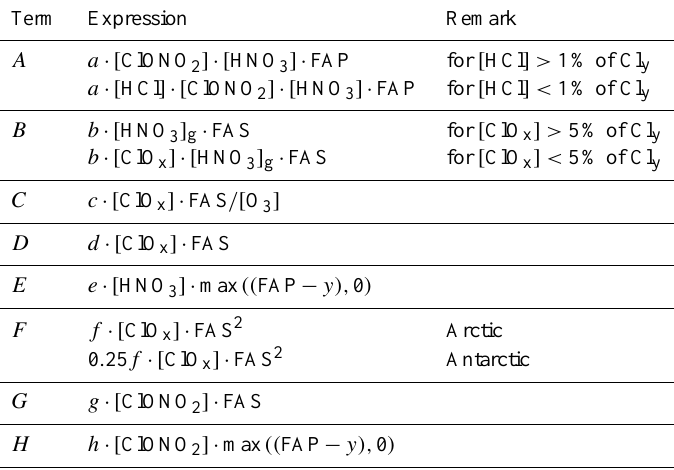
Table 2. List of the terms used in the differential equations. Term